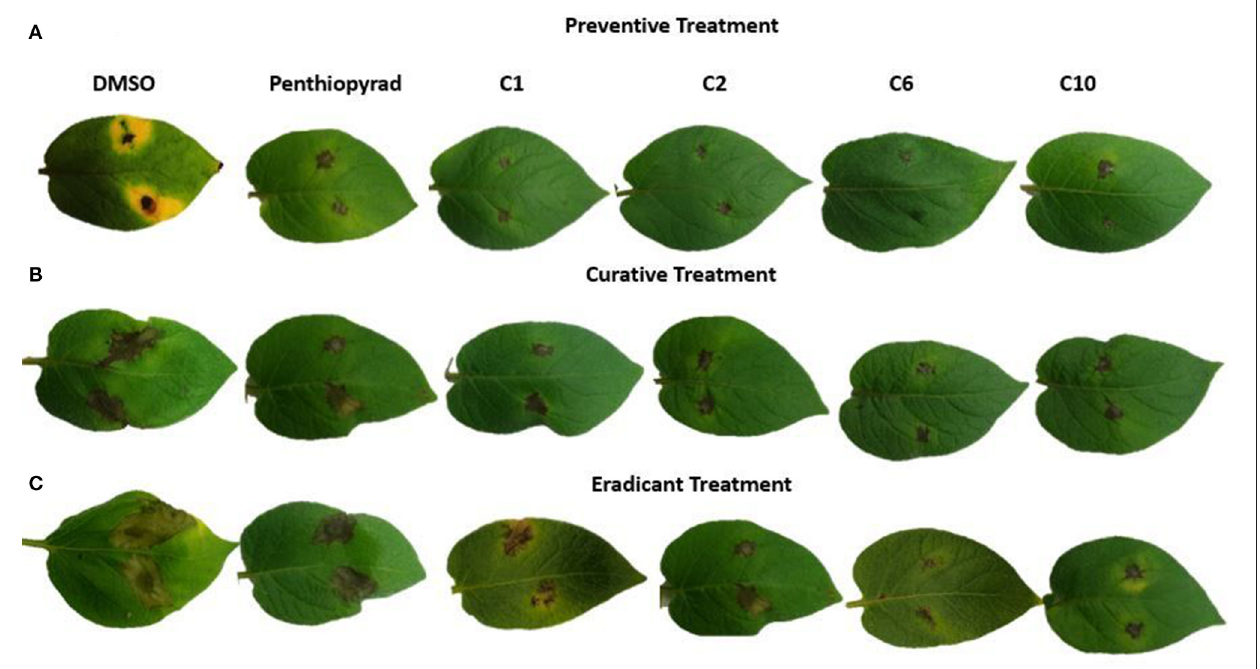
FIGURE 5 | Symptoms of A. solani infection on spot-inoculated potato leaves treated with C1 , C2 , C6 , and C10 at 5 dpi (A) Preventive treatment (B) Curative treatment (C) Eradicant